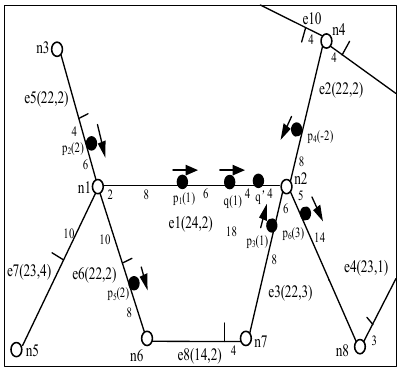
Figure 8. The Local Road Network.